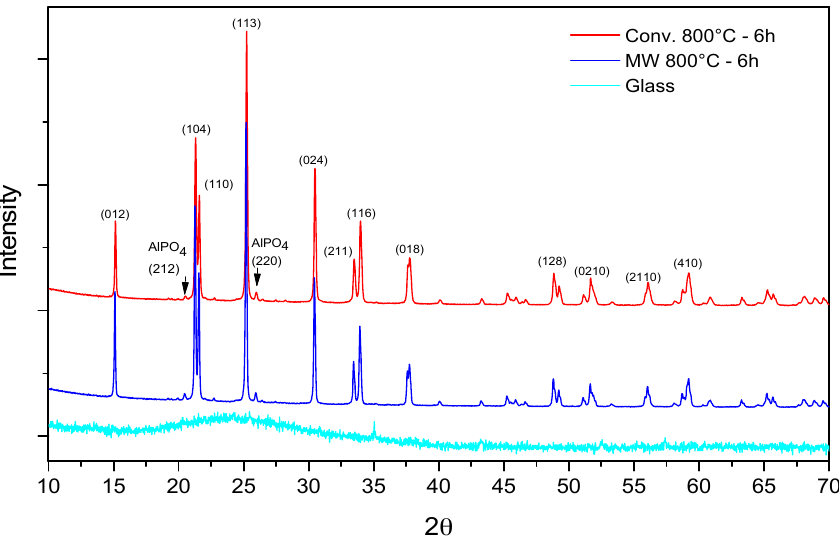
Figure 3. Comparison of XRD patterns of LAGP glass and glass-ceramics samples heat-treated at 800 °C for 6 h using 30 GHz microwave and conventional heating.